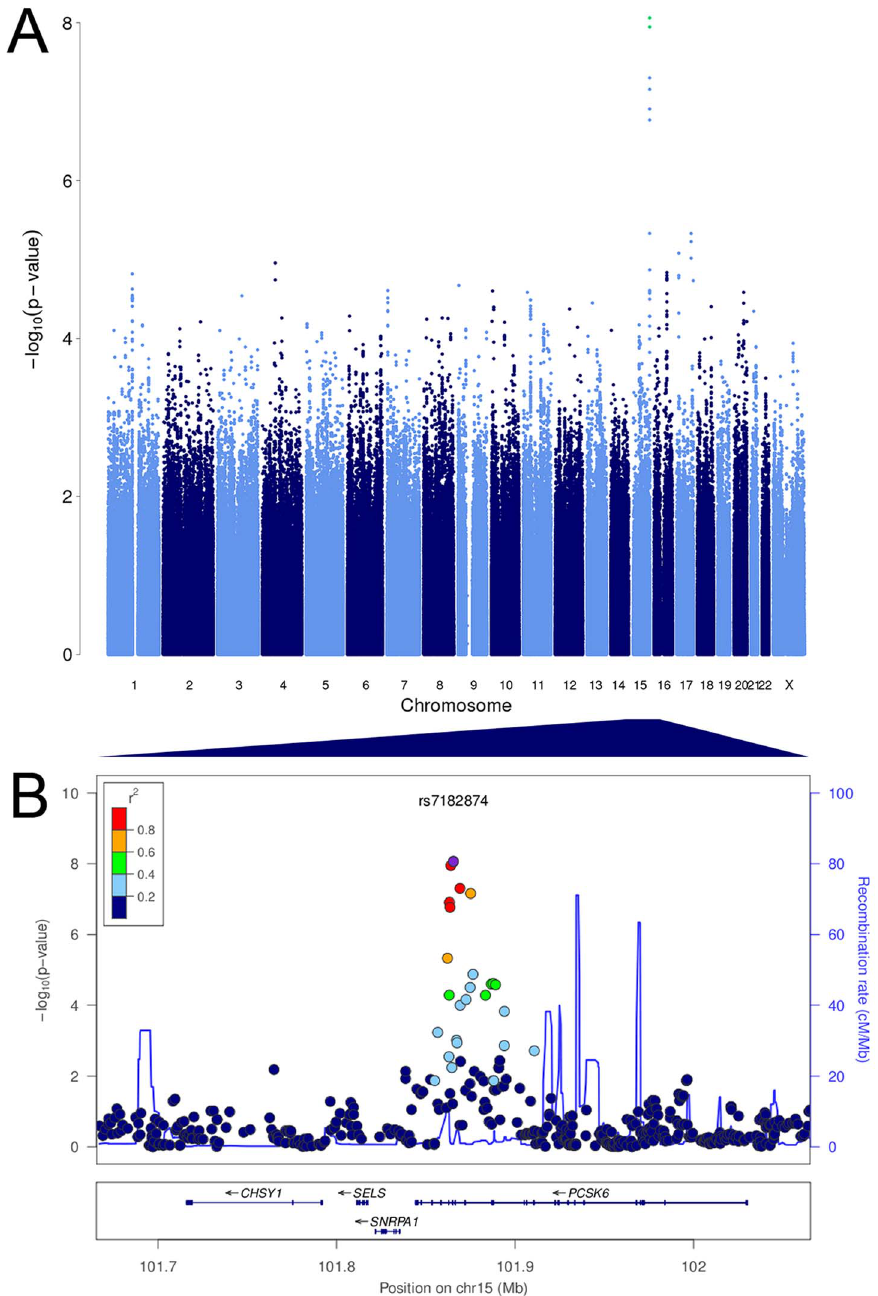
Figure 1. PCSK6 is associated with relative hand skill in individuals with reading disability. Manhattan plot and visualization of P-values at the PCSK6 locus. (A) Manhattan plot of the P values for the meta-analysis of the RD Peg relative hand skill GWAS data-sets (cohorts 1–3). The observed P values are plotted against chromosome and position along the genome. The green dots represent markers that are genome-wide significant at P # 5 6 10 2 8 . (B) Negative log 10 of the P-values for all genotyped and imputed SNPs around PCSK6 plotted in LocusZoom. Linkage disequilibrium (r 2 ) with the most highly associated SNP, rs7182874 (purple diamond), is shown by the color of the SNPs. The recombination rate is shown by the blue line and the locations of genes in this locus are shown in the panel below the plot. We took forward the four phenotypes that show an over- S5 ). We have therefore shown that our findings from the RD representation of genes with low P -value SNPs in the RD cohorts cohort hold true for the general population. for testing in the general population (cohort 4). Three out of the four phenotypes show enrichment at (FDR # 5%), double outlet right ventricle ( P = 0.019, adjusted for multiple testing), heterotaxia (adjusted P = 0.026), and situs inversus (adjusted P =0.021) ( Table